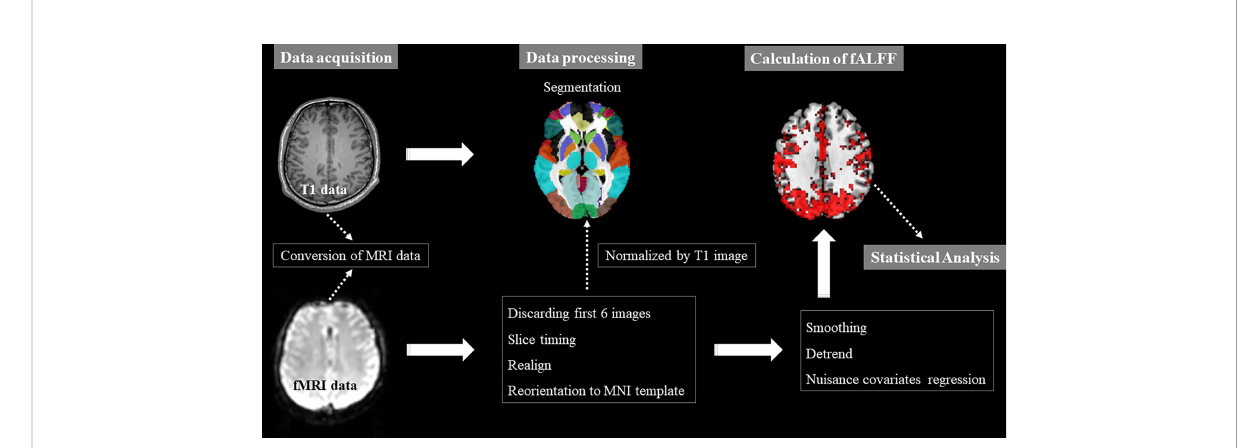
FIGURE 1 Pipeline of MRI data acquisition and processing, and fALFF calculation. fALFF, fractional amplitude of low-frequency fl uctuation; fMRI, functional magnetic resonance; MNI, Montreal Neurological Institute; x, y and z: the coordinates of peak voxel of each cluster in the MNI